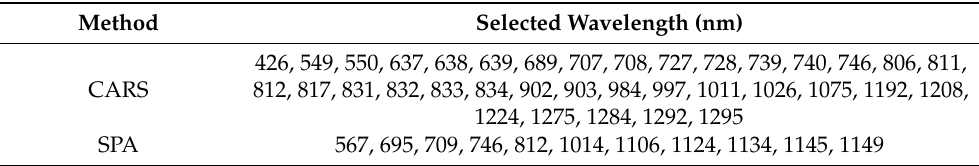
Table 3. Characteristic wavelengths.